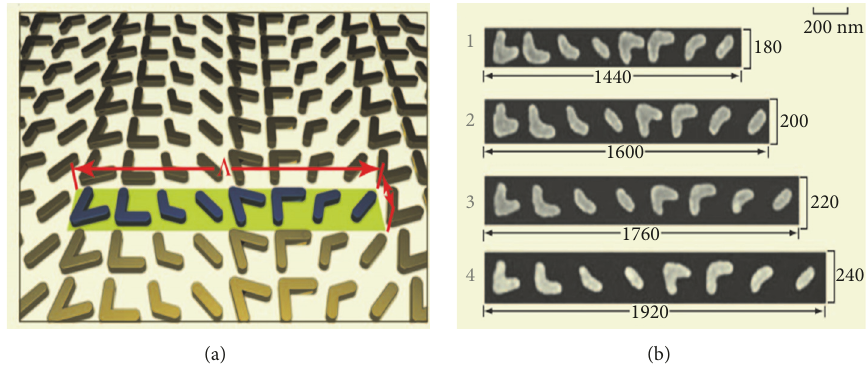
Figure 4: Schematic representation of a nanoarray. (a) The unit (blue) at the plasmonic interface is composed of 8 metallic V-shaped antennas with a width of 40 nm and a thickness of 30 nm. The repetition period in the x direction is T, and the repetition period in the y direction is T/8. The phase delay of cross-polarized light increases from right to left along the x axis. (b) The scanning electron microscopy images of four antenna array cells with different cycles were produced on a single